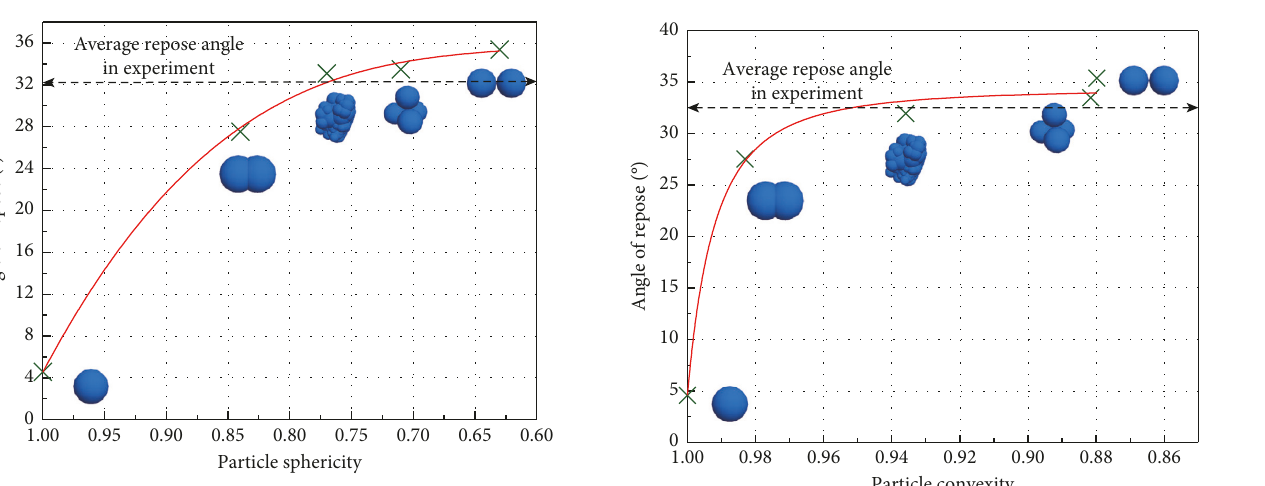
Figure 13: The effect of particle sphericity on the angle of repose.